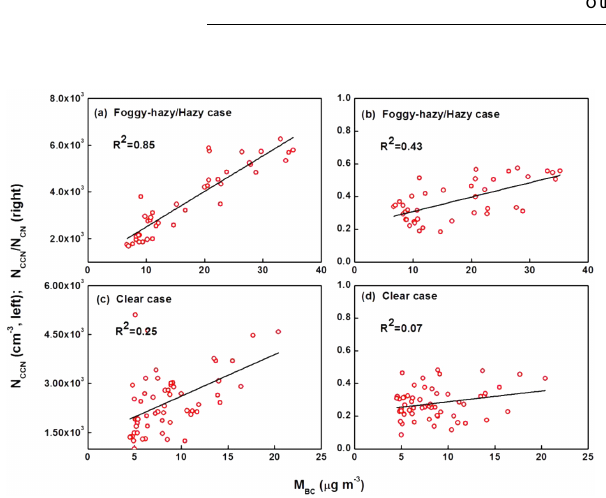
Figure 11. Correlations of observed and predicted N CCN (0.2%